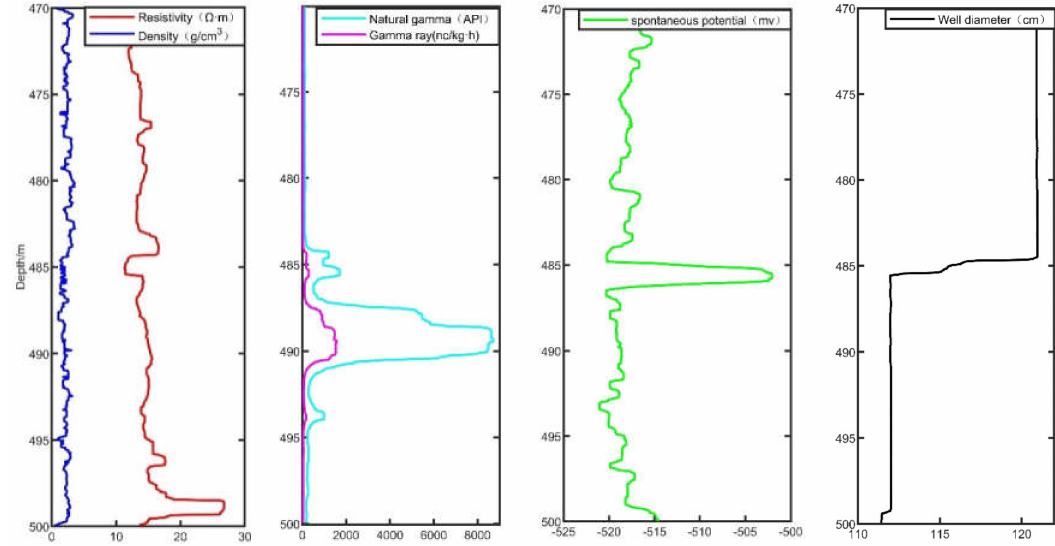
Figure 7. Logging curve of Borehole ZKC232-87 of the Tarangaole deposit.